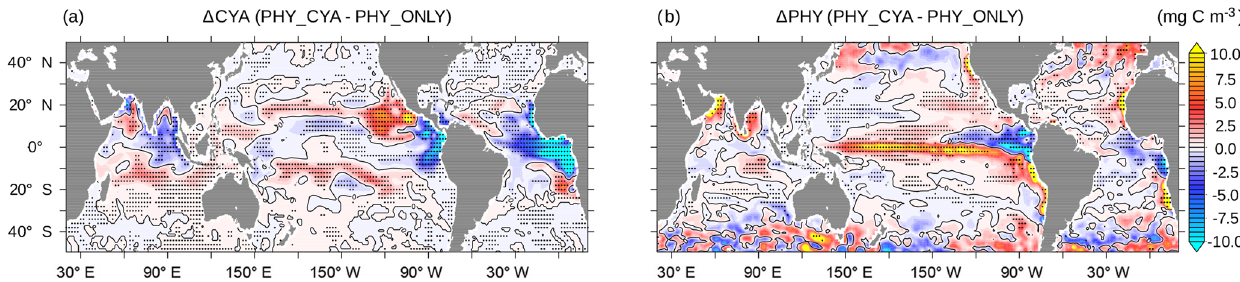
Figure 7. Change in (a) climatological annual mean surface (0–22m) cyanobacteria concentrations (mgCm − 3 ) and (b) surface bulk phyto- plankton concentrations (mgCm − 3 ) between PHY_CYA and PHY_ONLY. The zero isolines are overlaid in black. The dotted areas indicate statistically significant anomalies at the 90% confidence level (student’s t